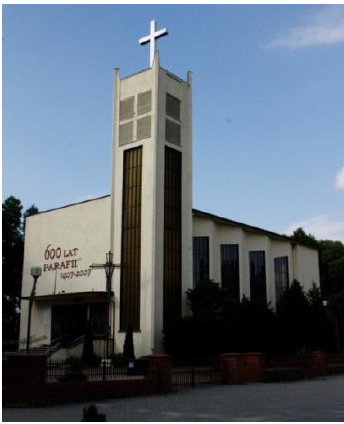
Figure 4. Church of St. Stanislaus in Biała Górna (built in 1967–68).